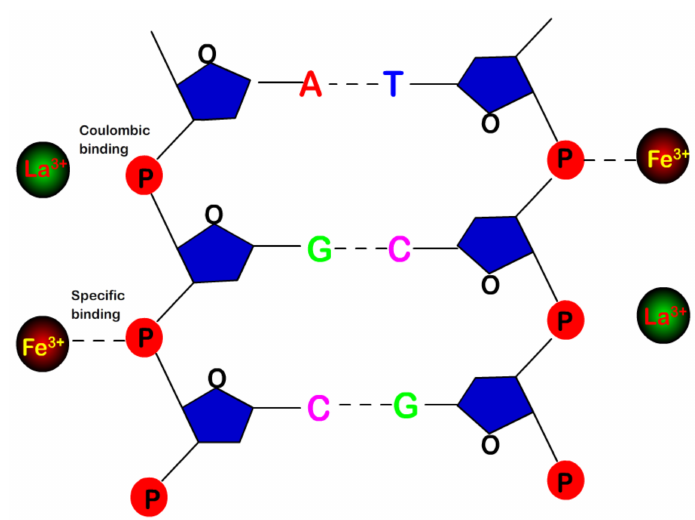
Figure 6. Schematic representation of the bindings of Fe 3+ and La 3+ to phosphates of DNA backbone, where the Fe 3+ binding depends on its character in the solution and is highly specific, similar to covalent bond, while La 3+ binding is electrostatic and sensitive to surface